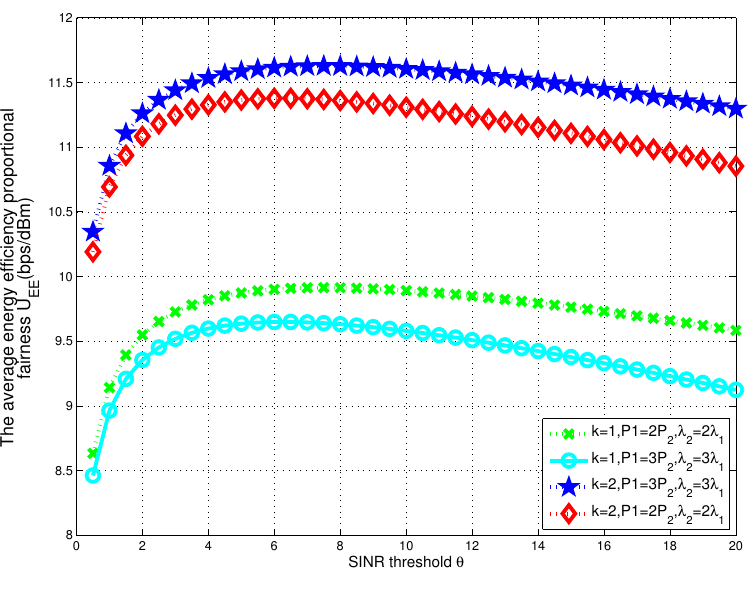
Figure 2. The relationship between energy efficiency proportional fairness utility function and the receive threshold for different transmit powers and densities of BSs in two-tier heterogeneous